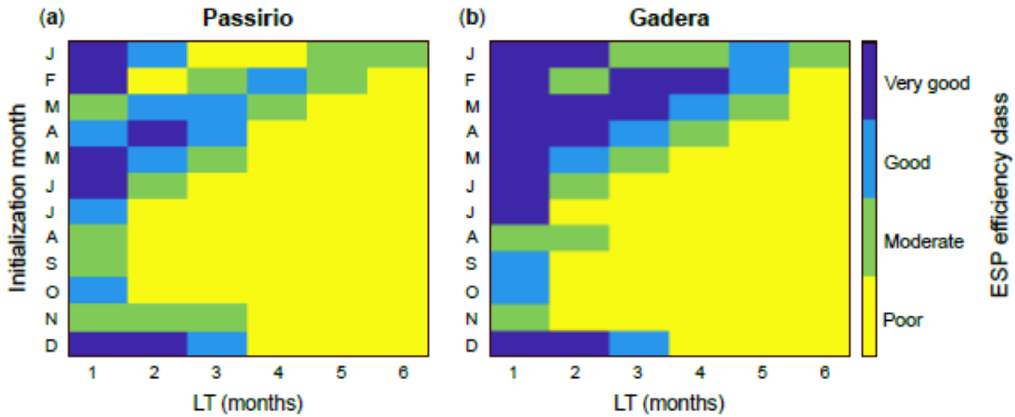
Figure 12. Classification of the ESP efficiency ( a ) for the Passirio catchment; and ( b ) for the Gadera catchment, for each initialization month (along each line) and LT (along each column). Four ESP efficiency classes can be distinguished; very good: more than 75% of the forecast skill originates from knowledge of IC; good: 50% to 75% of the forecast skill originates from knowledge of IC; moderate: 25% to 50% of the forecast skill originates from knowledge of IC; poor: less than 25% of the forecast skill originates from knowledge of IC.